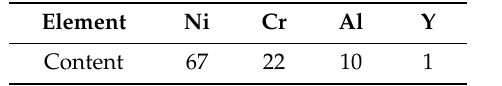
Table 1. Chemical composition of feedstock powder (wt.%).